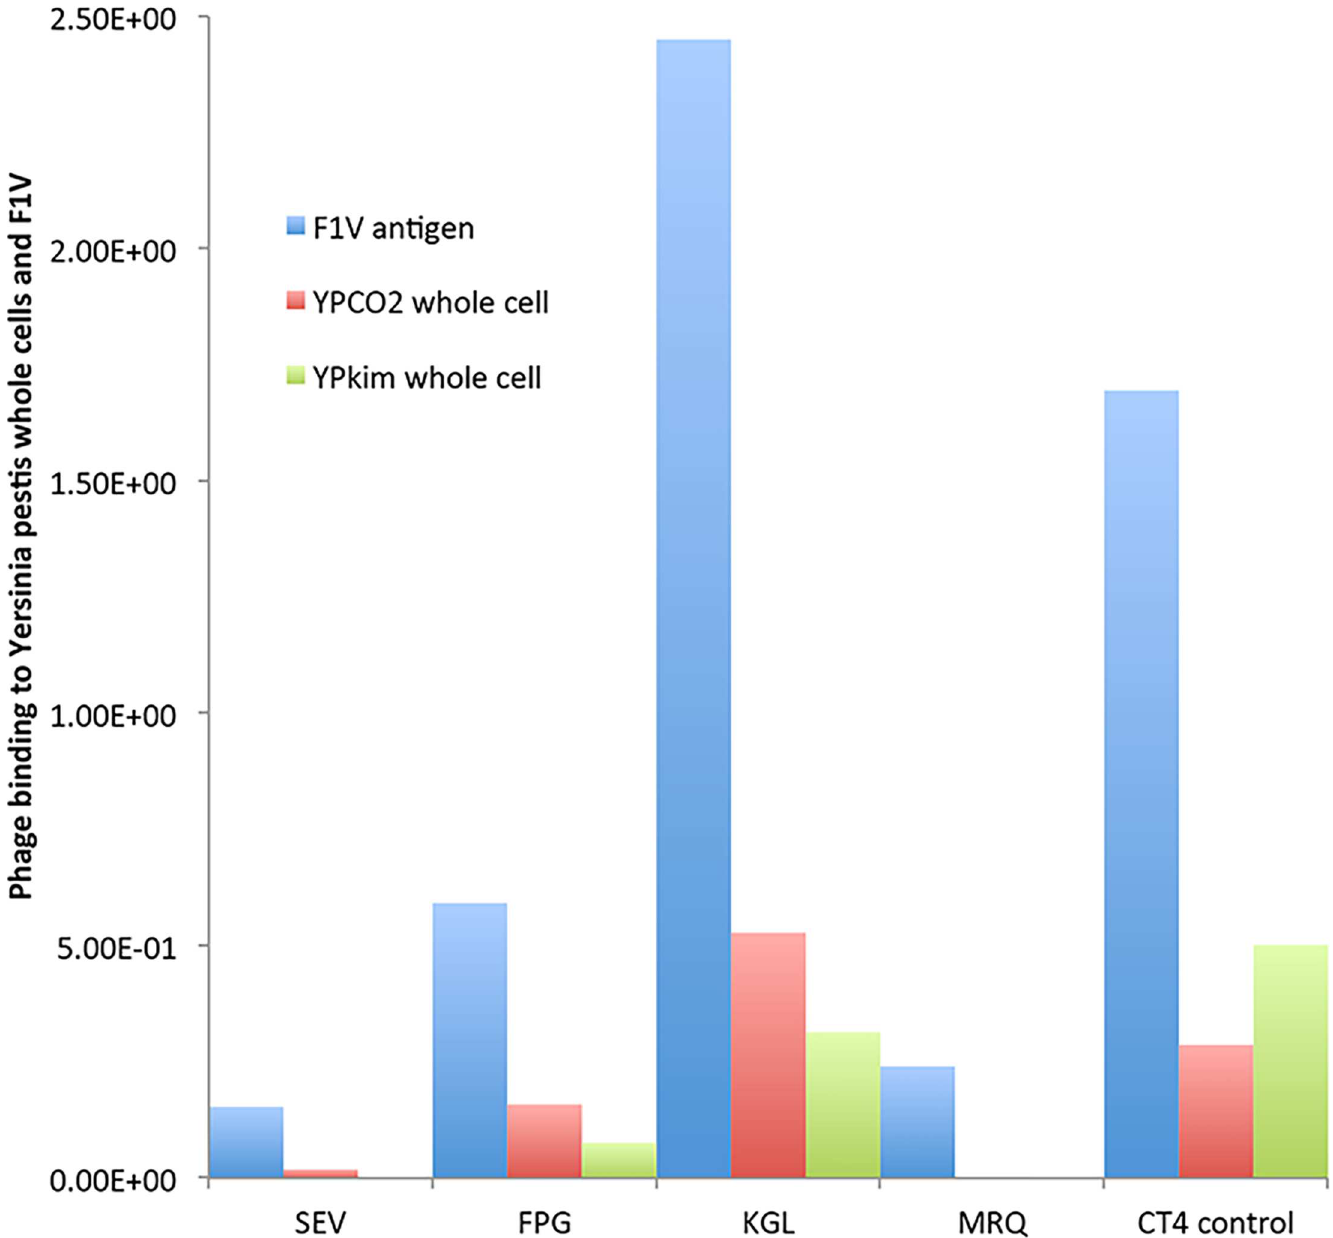
Fig 4. Two peptideclones recognize live wholecell Y . pestis as wellas purifiedF1V antigen. Phage supernatants producedfromclones randomly picked fromselectionoutputswere assayed for bindingto F1V-coated, whole cell-coated and uncoated wells. CT4 control is an scFv identifiedas positive froma previous selectionon F1V [23].Phage bindingwas detectedwith anti-M13-HRP conjugated antibody. The signal obtainedwith uncoated wells was subtracted fromthe signalcorresponding to coatedwells, and the resultswere normalizedbased on phage